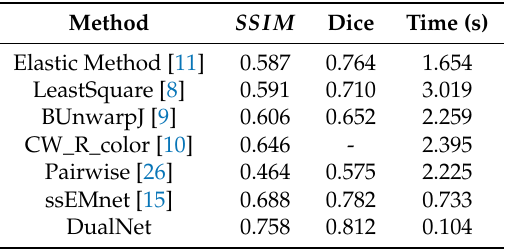
Table 3. Quantitative results comparison on fly brain image